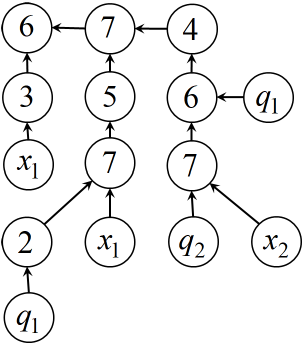
Figure 1. Computational tree of genetic